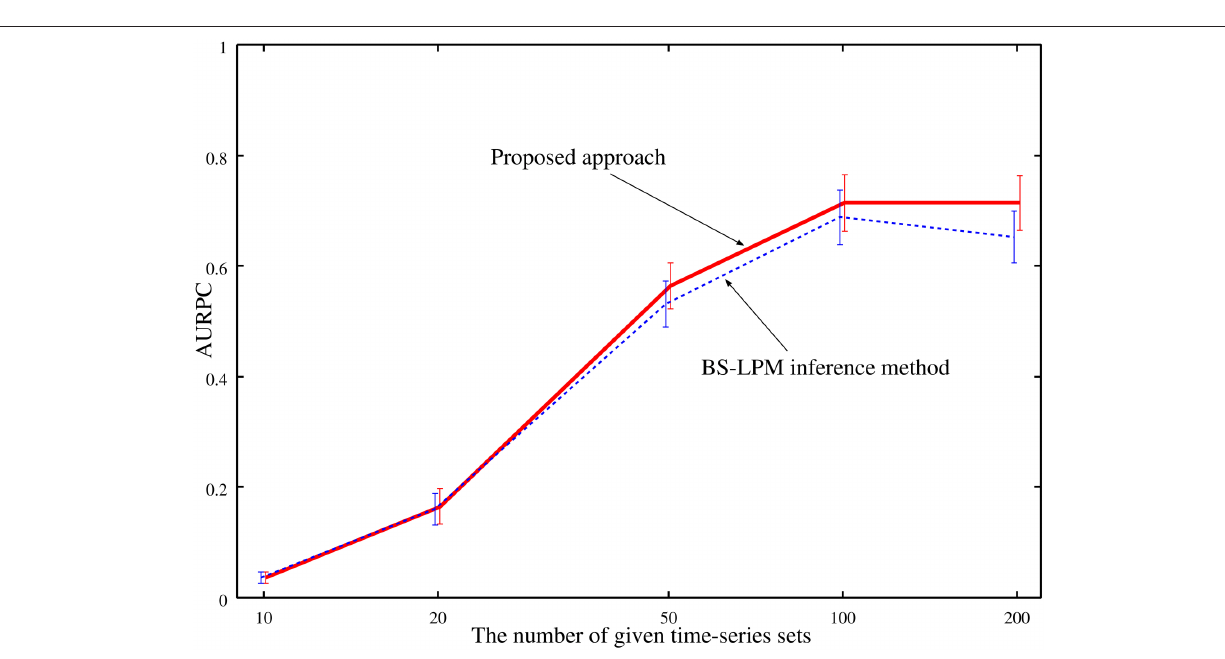
introducing this a priori knowledge, we reduced the